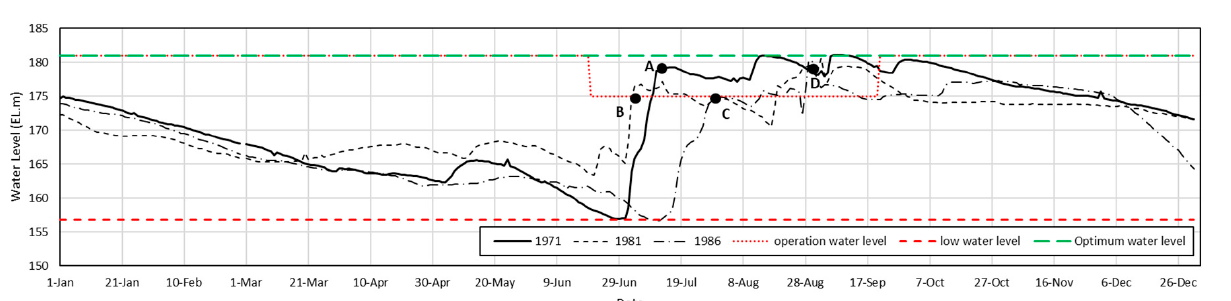
Figure 7. Comparison of dam water level by year. Table 2. Comparison of hydrological data and resilience (All seasons are full year and the Flood season is from June 21st to September 20 th).